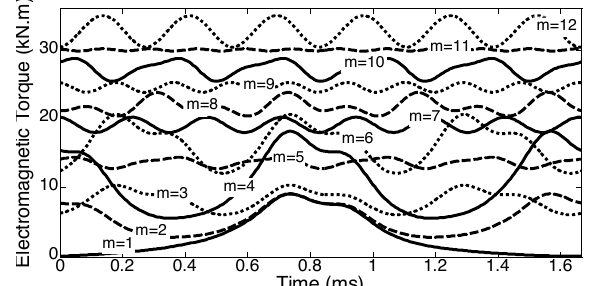
Figure 9: Electromagnetic torques of a few Claw Pole TFPM motors with different phase number.